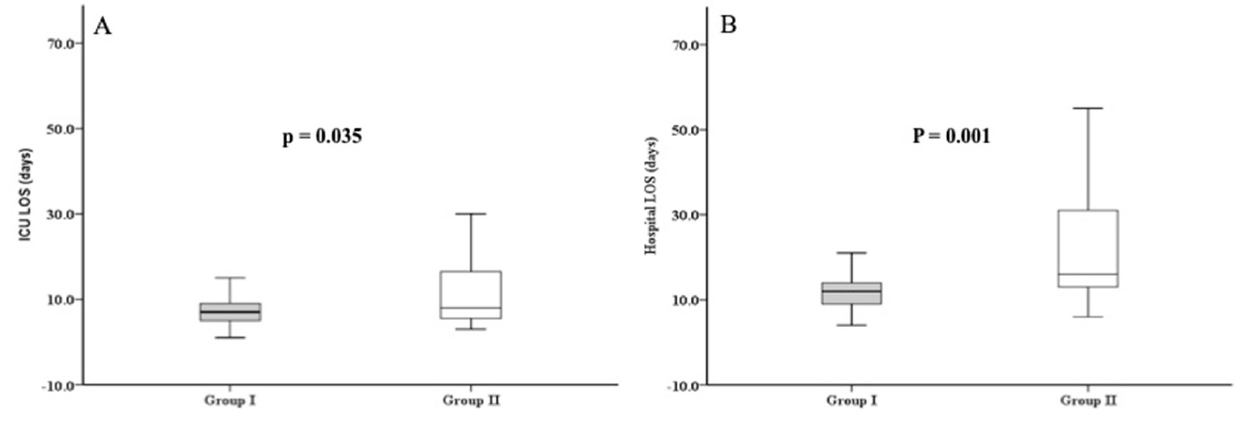
Fig. 1 - Demonstration of the association of a neutrophil-lymphocyte ratio > 0.80 with prolonged intensive care unit (ICU) length of stay (LOS) (A) and hospital LOS